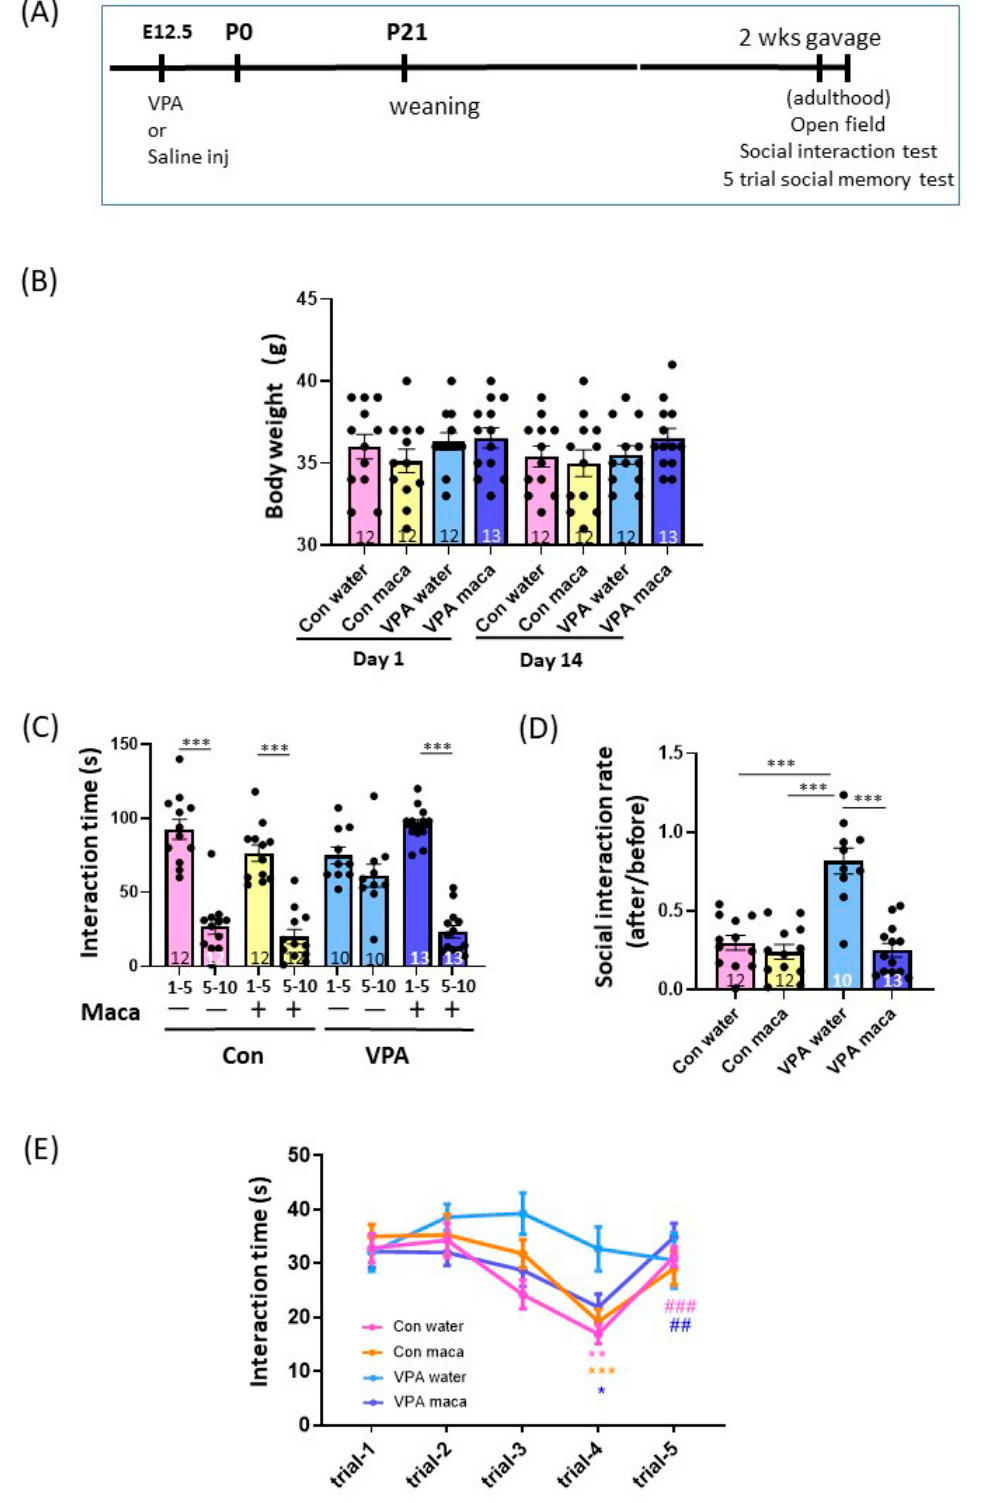
Figure 3. Maca improved the deficit of social behavior and social recognition memory. ( A ) Experi- mental design. Adult mice were gavaged with maca or water once daily for 2 weeks. Mice underwent either social interaction test, 5-trial social memory test, or an open field test after gavage. ( B ) No significant change in the weight of the mice before and after maca treatment. ( C , D ) The time of interaction with an unfamiliar female mouse in the first and last 5 min of the test was analyzed. ( C ) Interaction time of the first 5 and last 5 min of the test of either gavaged with water or maca. ( D ) Social interaction rate. ( E ) Interaction time in 5-trial social memory test (Con and VPA water, n = 8,